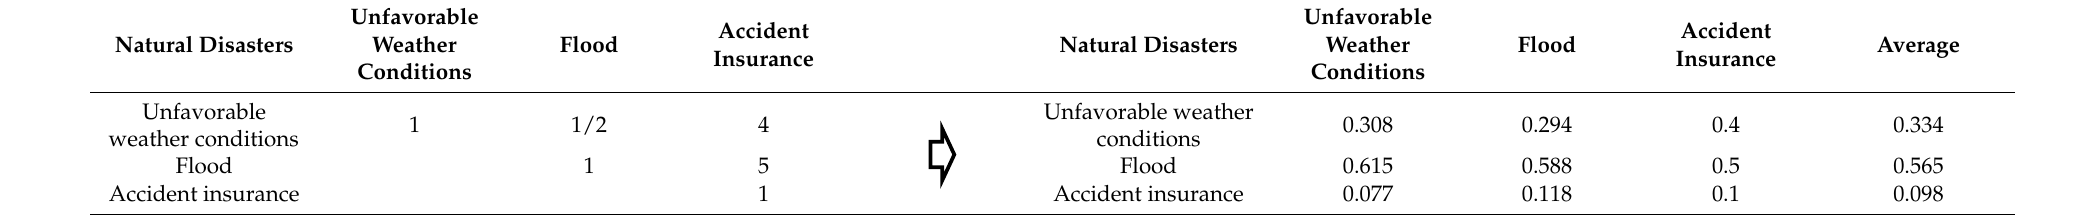
Table 4. The pairwise comparisons matrix for lands’ funding. Table 5. The pairwise comparisons matrix for management problems. Table 8. The pairwise comparisons matrix for natural disasters.